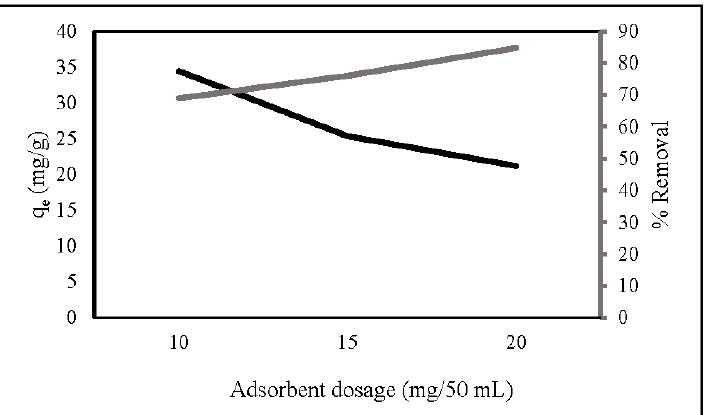
Figure 4. Effect of ZLCH-Fe dosage on the nitrate adsorption. (Initial NO 3 : 10 mg/L; contact time: 30 min; pH: 7.)